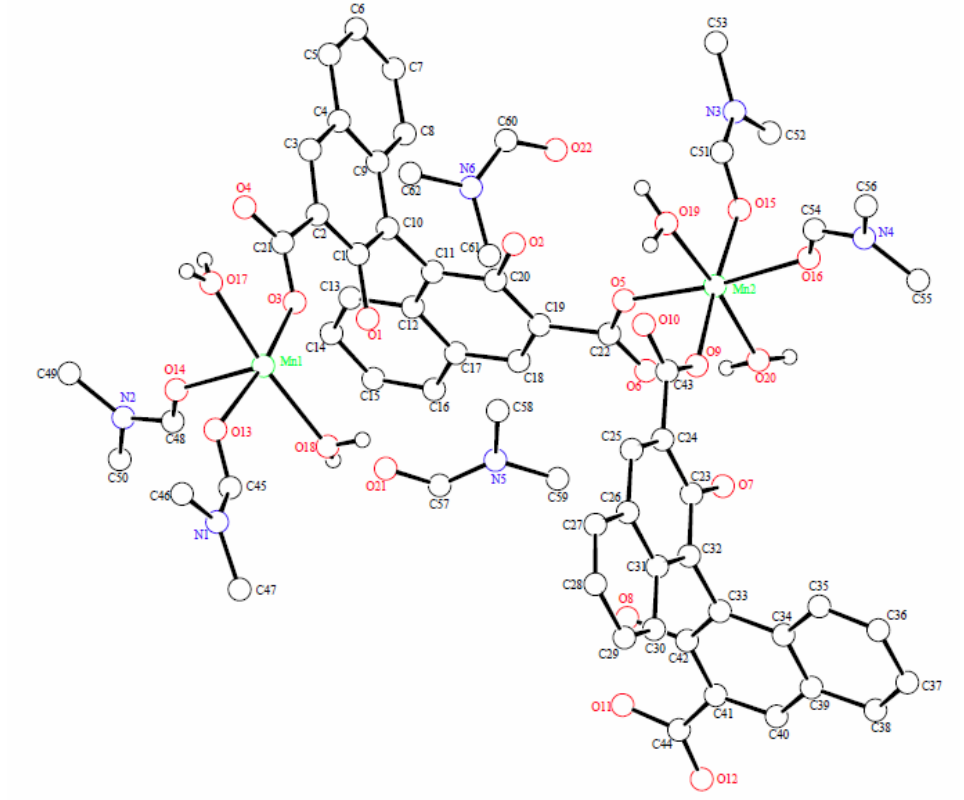
Figure 3. Structure of ( R )-MOF- 2 in an asymmetric unit and atomic numbering system. Hydrogen atoms, excluding those of water, are omitted for clarity.